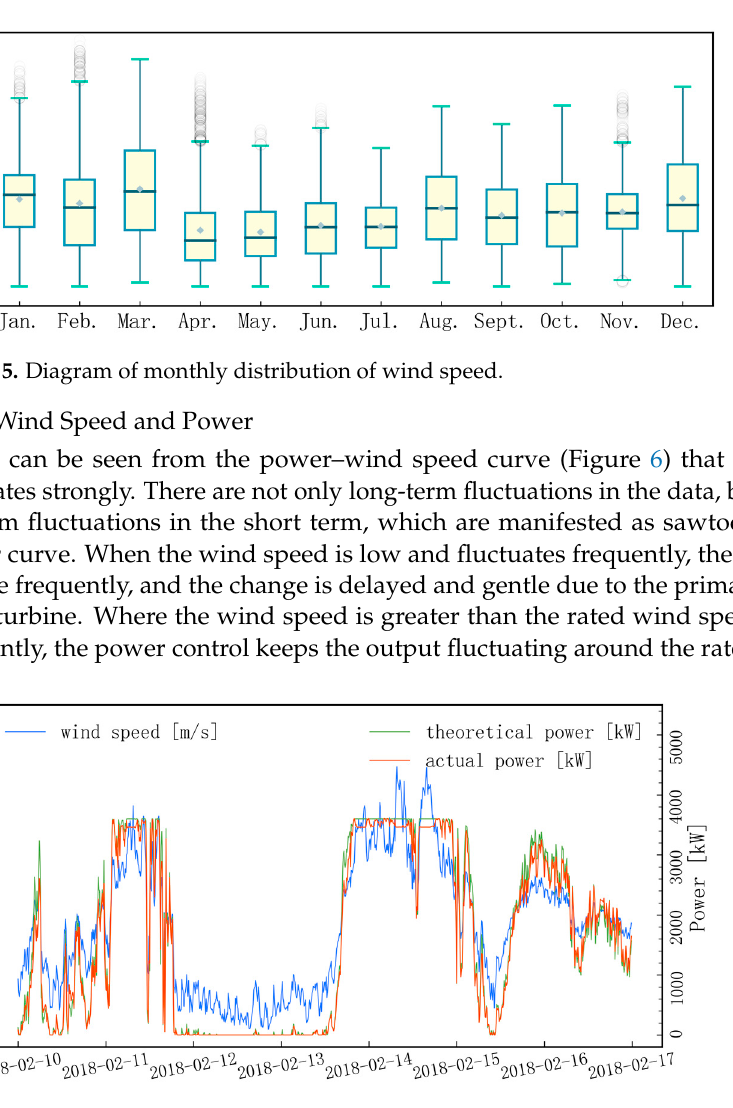
Figure 4. Schematic diagram of data processing flow of supervised learning task.